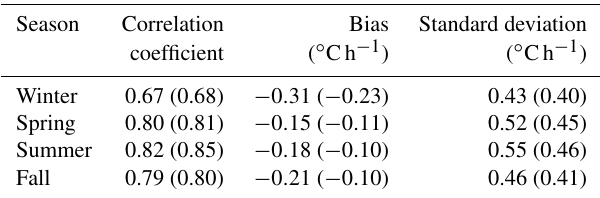
Table 2. Statistics values between ∂T 2m four seasons of the year. The values in brackets correspond to the statistics within the 5th and 95th